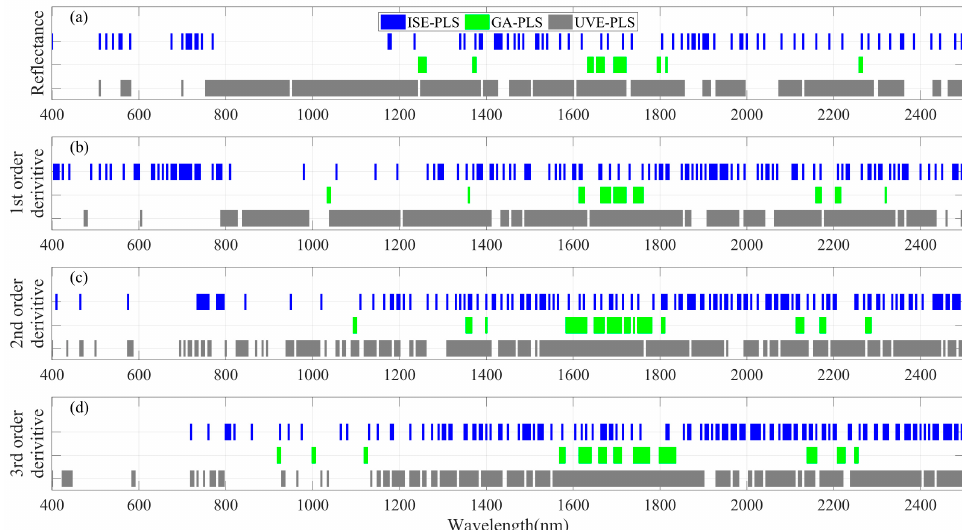
Figure 4. Distribution of bands selected with different band-selection methods for LNC estimation from spectra within 400–2500 nm. ( a ) Reflectance. ( b ) The 1st-order derivative spectra. ( c ) The 2nd- order derivative. ( d ) The 3rd-order derivative. The locations of the color blocks in the Wavelength-axis represent the bands involved in different PLS (blue for ISE-PLS, green for GA-PLS and grey for UVE-PLS) regression models.